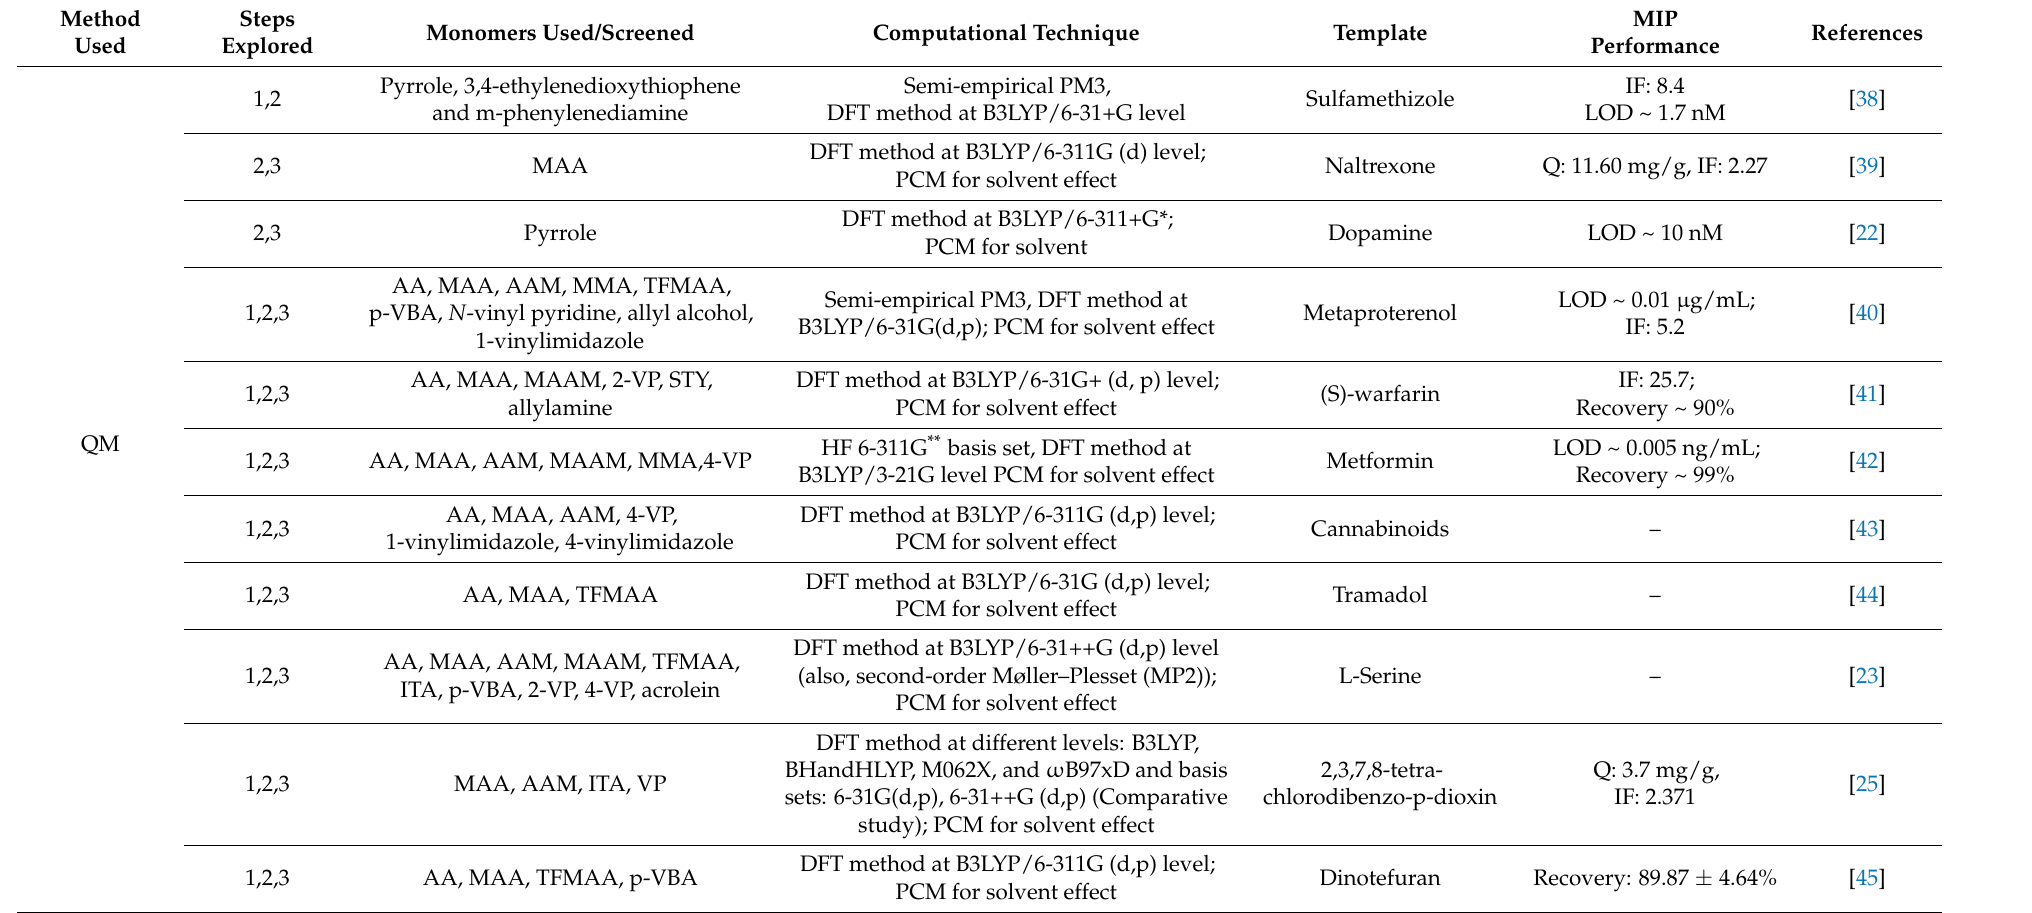
Table 1. Molecularly imprinted polymers designed with computational intervention at multiple steps using quantum mechanics (QM), molecular mechanics